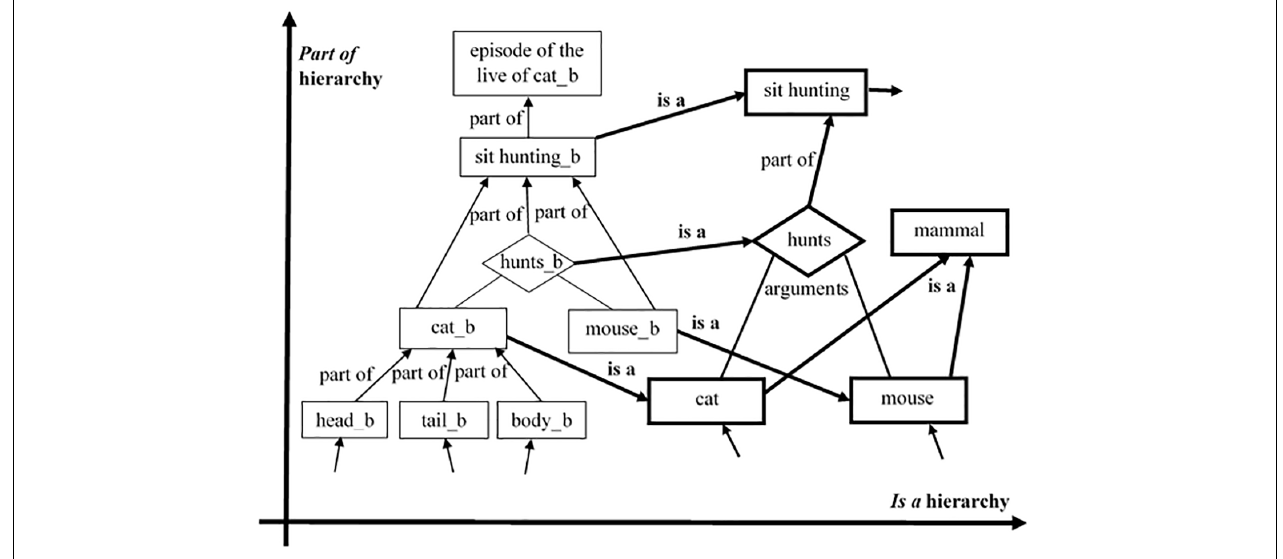
FIGURE 3 | Part of the RoleMa p’s knowledge representation, representing the two-dimensional structure through the is a and the part of hierarchies. The bold items point to concepts (All links are bi-directional).